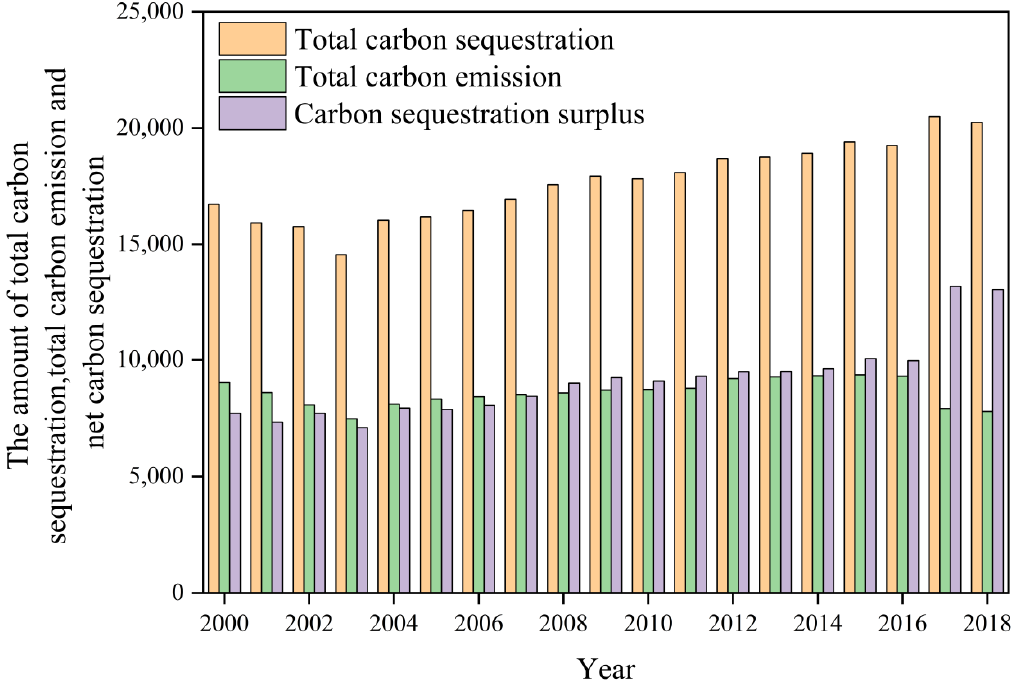
Figure 4. The total carbon sequestration, total carbon emission, and net carbon sequestration from food crops in the YREB (10 4 t C).